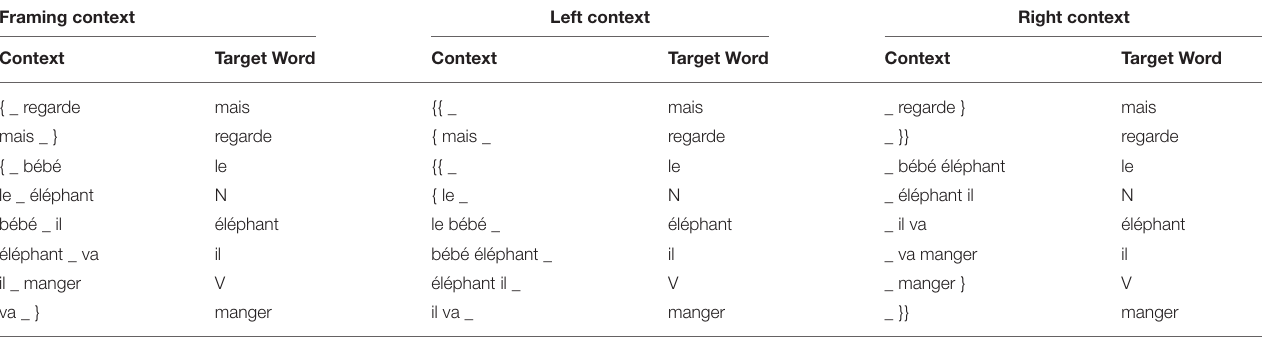
TABLE 2 | The trigrams that are counted for the sentence “ Mais regarde, le bébé éléphant il va manger. ” ( But look, the baby elephant is going to eat. ). Framing